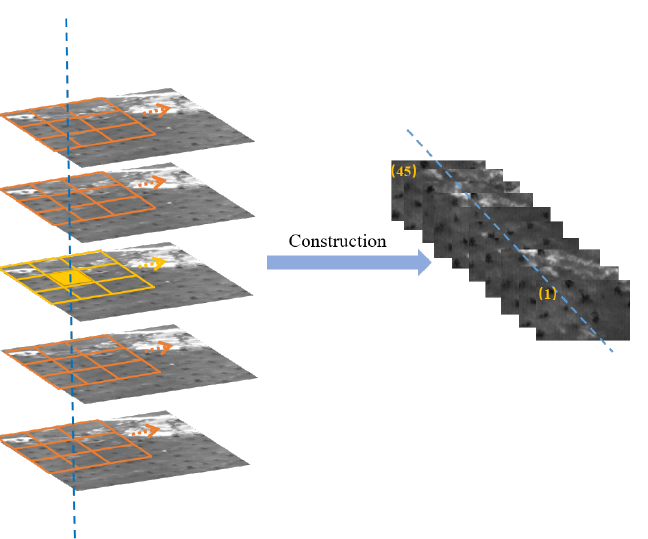
Figure 5. The proposed tensor construction method by fully using spatial and temporal information.